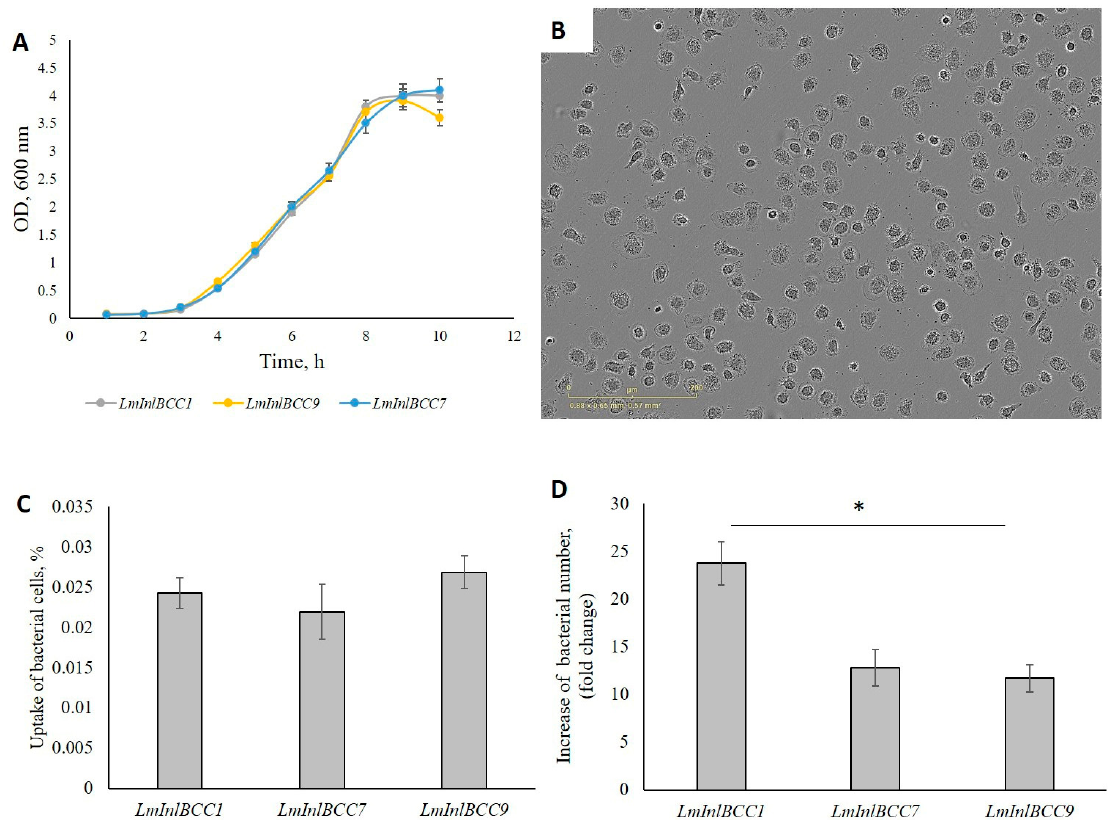
Figure 3. Interaction of M1-phenotype macrophages with isogenic strains of L. monocytogenes . Bacteria were added to the macrophages in MOI 1:100, incubated for 1 h. To destroy extracellular bacteria, gentamicin was added at a concentration of 100 µ g mL − 1 and incubated for 1 h. To assess the effectiveness of bacterial capture, macrophages were washed three times with PBS and 1% triton X-100 were lysed. In the analysis of intracellular reproduction, the medium was replaced with a supportive one with the addition of gentamicin 20 µ g mL − 1 and after 24 h macrophages were washed three times with PBS and 1% triton X-100 were lysed. After cell lysis, serial dilutions were made. ( A ) Growth curves of three isogenic strains LmInlBCC1 , LmInlBCC7 and LmInlBCC9 ; ( B ) Morphology of cells derived from blood monocytes of healthy donors. The cells have characteristic outgrowths on the cell surface and a large rounded nucleus. The photos were obtained using the IncuCyte ® S3 Live Cell Imaging System (Sartorius; Göttingen, Germany); ( C ) The uptake of isogenic recombinant strains of L. monocytogenes into M1-phenotype macrophages. The f-ratio value is 2.63602. The p -value is 0.104461. The result is not significant at p < 0.05 (n = 4); ( D ) An increase in the number of bacteria of isogenic strains of L. monocytogenes in macrophages of M1-like phenotype within 24 h after infection (* the p -value between LmInlBCC1 and LmInlBCC7/LmInlBCC9 is <0.05, n =